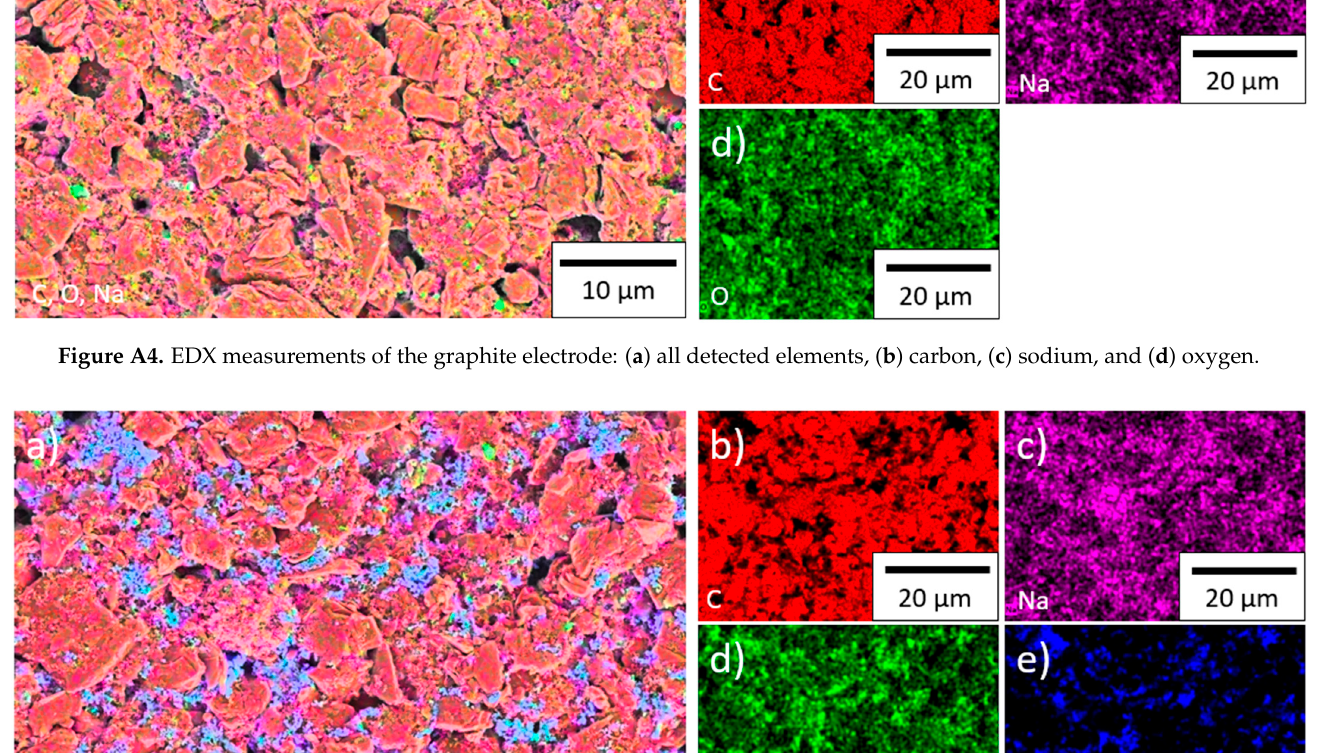
Figure A5. EDX measurements of the NGP electrode: ( a ) all detected elements, ( b ) carbon, ( c ) sodium, ( d ) oxygen, and ( e ) silicon.